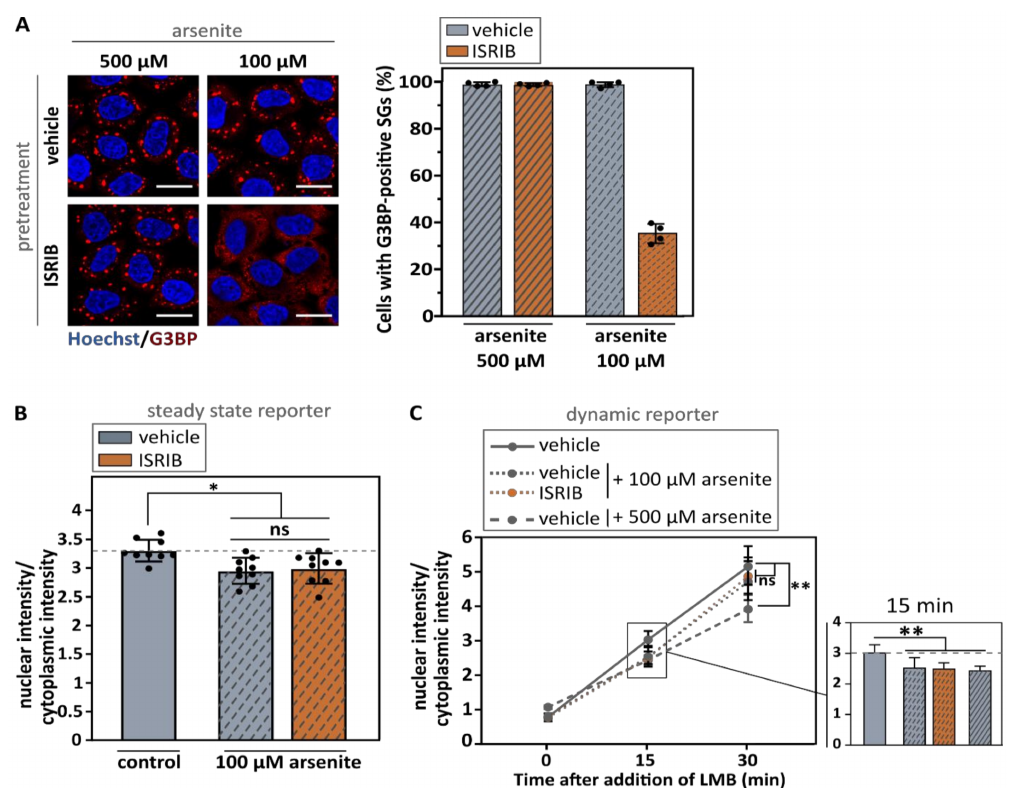
Figure 4. Suppressing stress granule formation via inhibition of the integrated stress response does not rescue arsenite-induced import deficits. ( A ). HeLa Kyoto cells were pre-incubated with 2 µ M ISRIB (or vehicle) 4 h before treatment with the indicated arsenite concentrations. Cells were fixed with 4% PFA and stained with an anti-G3BP antibody. Stress granule formation was suppressed in cells treated with 100 µ M arsenite, but not with 500 µ M arsenite. The percentage of cells containing G3BP-positive granules was counted in four experiments. Each dot represents the average of one experiment with 50–200 cells per experiment. Mean ± SD. Scale bar = 20 µ m. ( B , C ). HeLa Kyoto cells expressing the NLS c-myc -GFP 2x -NES ikb2 reporter ( B ) or the NLS SV40 -mNeonGreen 2x -NES pki reporter ( C ) were incubated with 2 µ M ISRIB (or vehicle). After 4 h, cells were treated with indicated concentrations of arsenite, before measuring the nuclear and cytoplasmic intensity of the reporter. A zoom in on time point 15 is shown in the bar graph of panel ( C ). Data were automatically analyzed (High Content Imager). No rescue of arsenite-induced transport deficits was observed. Kruskal–Wallis test followed by Dunn’s multiple comparisons test. Data are shown as geometric means ± geometric SD. N = 6–9 (three experiments with each three wells, 1000 to 2000 cells per well—two experiments for 500 µ M arsenite). ns: no significant difference; * indicates p < 0.05; ** indicates p <